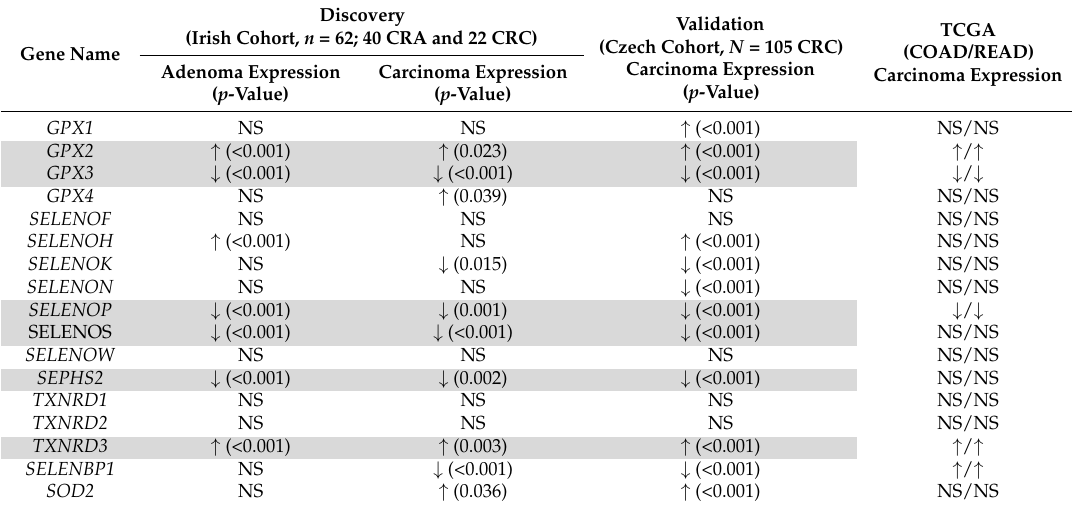
Differences in the transcript levels of the examined genes between the colorectal adenoma/carcinoma and the non-neoplastic tissue in the Irish and the Czech CRA/CRC patients (this study), and comparison with data from the TCGA patient